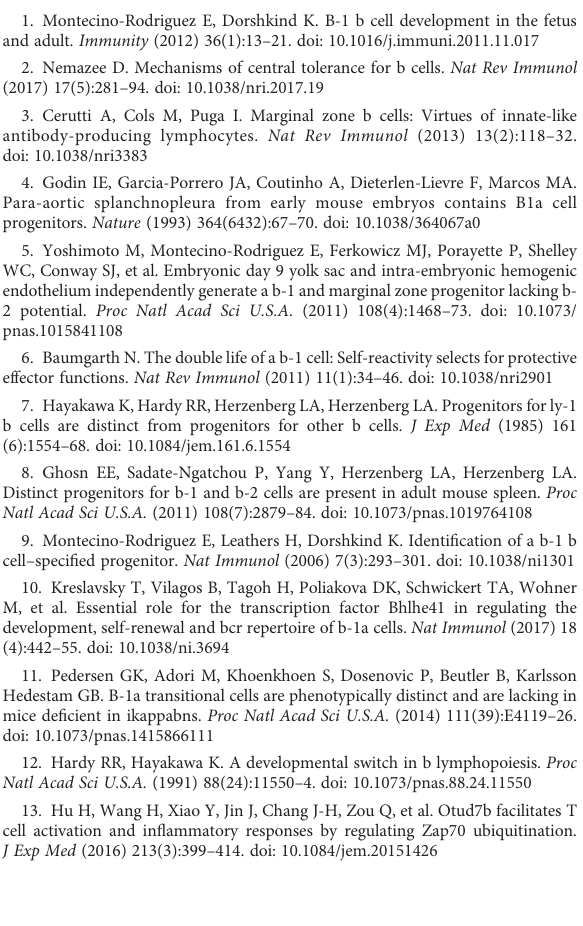
SUPPLEMENTARY FIGURE 1 Expression of Bhlhe41 in immune cells. The public gene expression microarray data (GSE15907) were quantile normalized and Bhlhe41 expression in murine immune cells was shown with arbitrary unit. LT, long term (LT); ST, short term; HSC, hematopoietic stem cell; MLP, multi- lymphoid progenitor, MDP, monocyte-dendritic cell progenitor; GMP, granulocyte-macrophage progenitor; MEP, megakaryocyte-erythrocyte progenitor; CLP, common lymphoid progenitor; CDP, common dendritic cellprogenitor;DN,doublenegative;DP,doublepositive;BM,bonemarrow; FL, fetal liver; ETP, early thymic progenitor; SP, single positive; NT, naïve T cell;MT,memoryTcell;pDC,plasmacytoiddendriticcell;cDC,conventional dendritic cells. NKT, natural killer T lymphocyte; NK, natural killer cell. SUPPLEMENTARY FIGURE 2 DNA sequencing of Bhlhe41 locus in Bhlhe41 dTomato-Cre mouse. The upper panel and lower panel show DNA sequence of the 5 ’ arm and 3 ’ arm of transgenic Bhlhe41 locus in Bhlhe41 dTomato-Cre mouse, respectively. SUPPLEMENTARY FIGURE 3 Expression of Bhlhe41 in tissues. (A) Expression of Bhlhe41 (dTomato + , green) in various tissues was examined by immuno fl uorescence analysis. (B) Analysis of Bhlhe41 expression (dTomato + , green) in microglia (Iba-1 + , red) and alveolar macrophage (CD68 + , red).